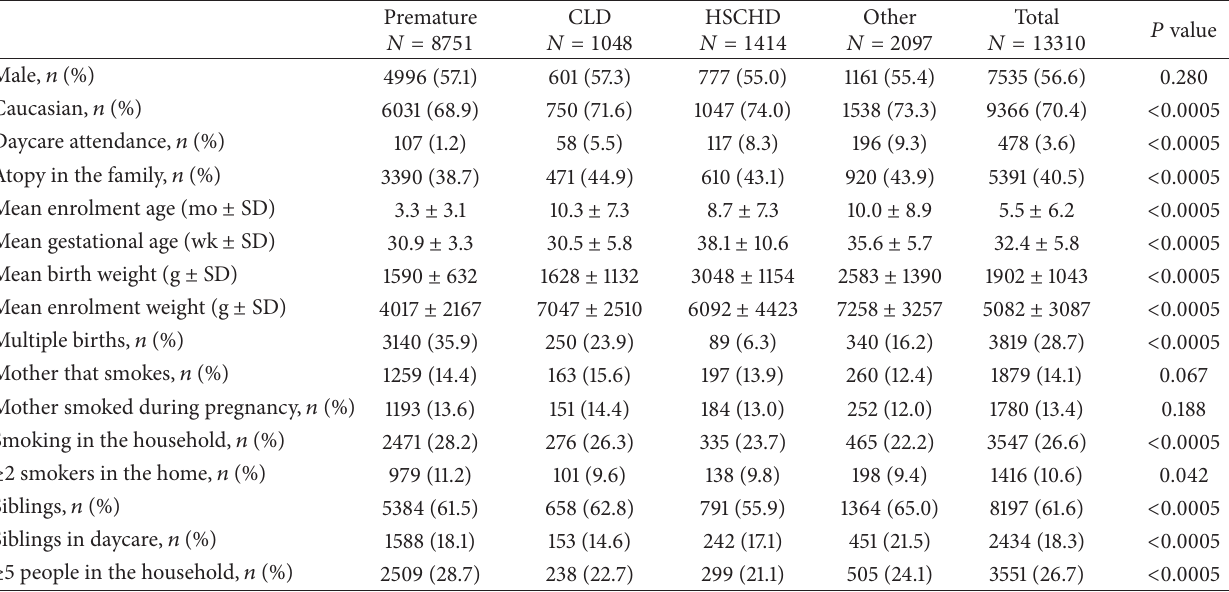
Table 1: Cumulative patient demographics by prophylaxis indication (2005–2012).